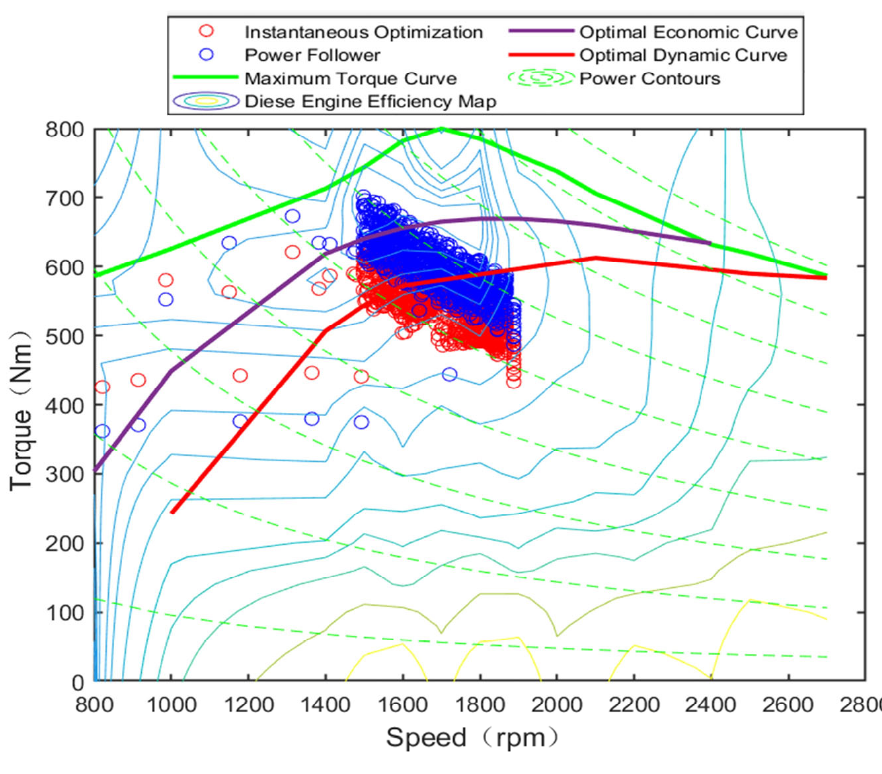
Figure 14. Diesel engine operating points.